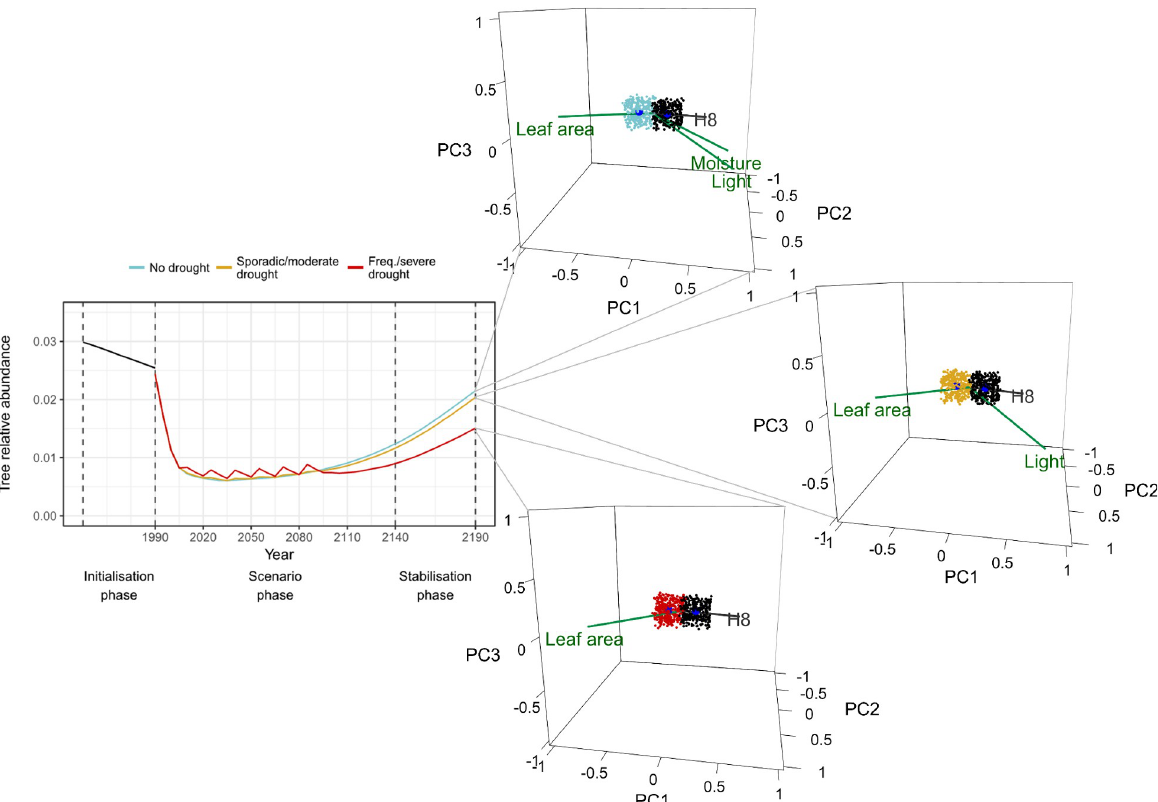
Fig 5. Unmanaged grasslands. Effects of different drought scenarios on tree transient dynamics and on community states represented by hypervolumes. Current (in black) and future (blue, yellow and red) state hypervolumes are shown with their centroids (in dark blue). Five PFGs with the largest absolute factor loadings on the first three principal components are shown in grey. Functional traits with highest correlations with PC1 (traits with absolute coordinate values � 0.8) are shown in green. Trait vector coordinates were scaled by the corresponding trait vectors’ correlations with ordination axes (only traits with absolute coordinate values � 0.8 on PC1 are shown). For visual clarity, only 300 random sampled points are shown per